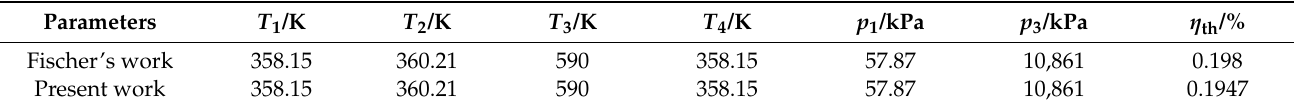
Table 1. Validation of the model.